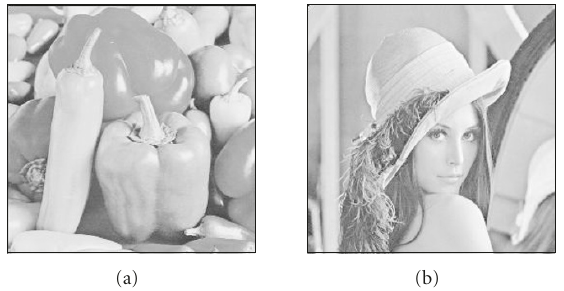
Figure 11: Original “Lena” and “Peppers” image : these images are shown for comparing them with the results presented in Figures 7 and 10,